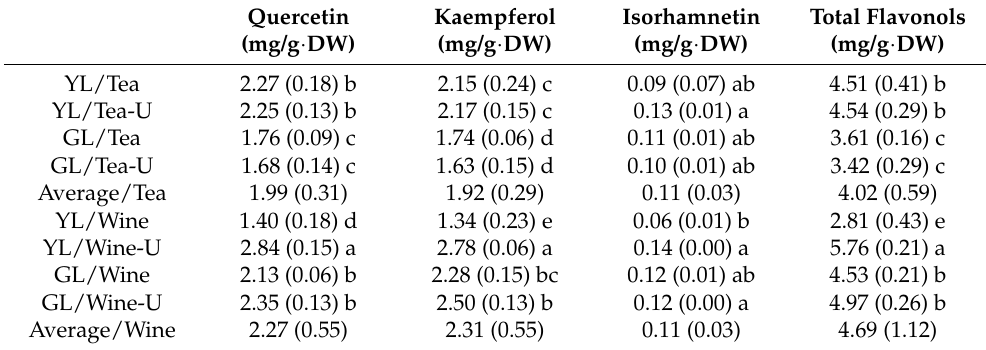
Table 2. Measurement of the total flavonol (TF) concentrations in GBE drinks.